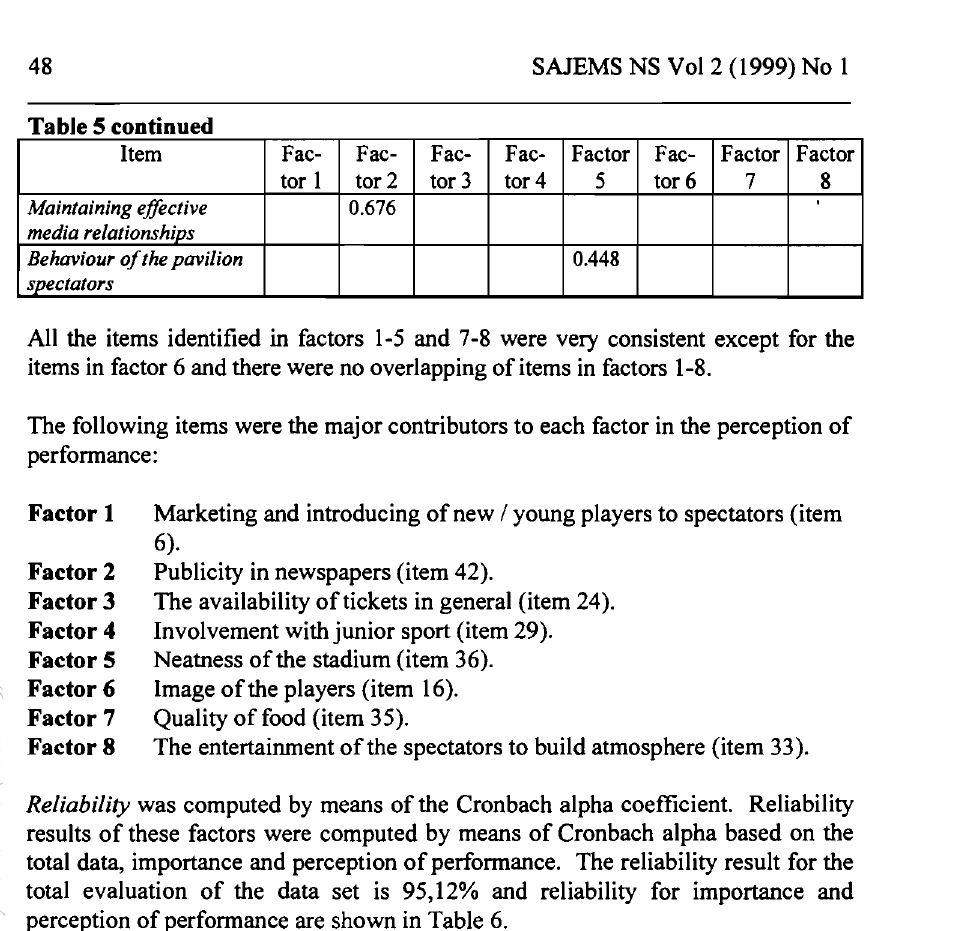
Reliability results based on importance and